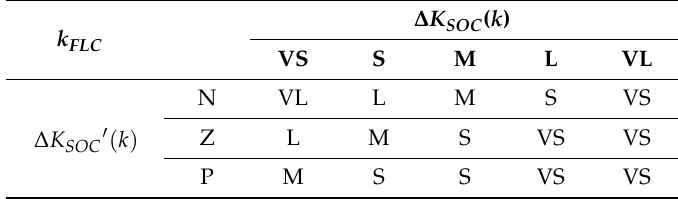
Table 4. Rules of the fuzzy logic control for linguistic variable.